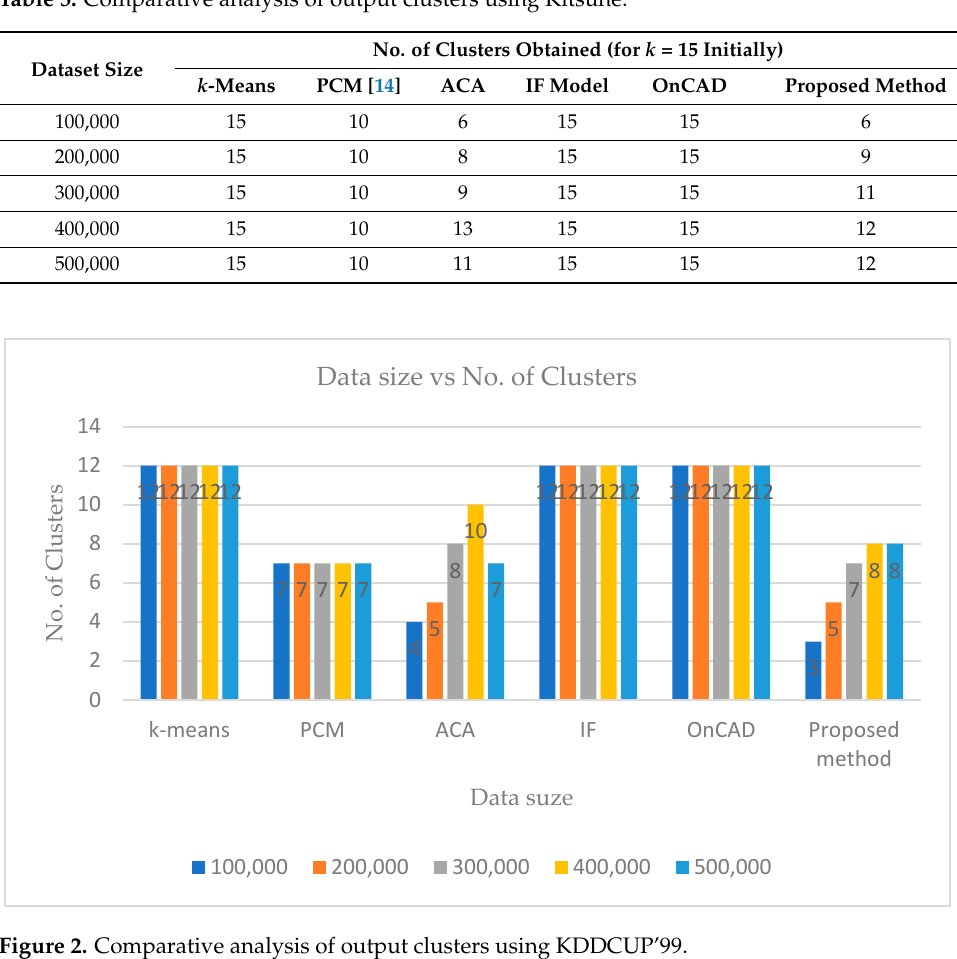
Table 5. Comparative analysis of output clusters using Kitsune.